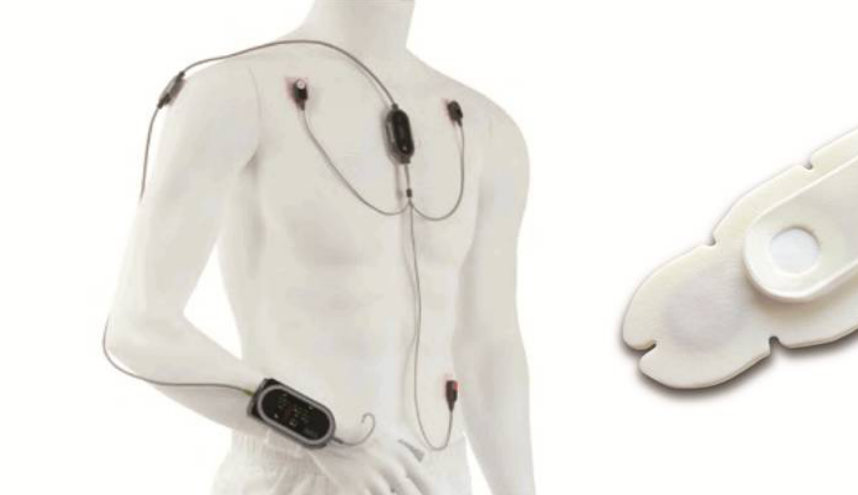
Figure 1. ViSi Mobile system (left) and HealthPatch